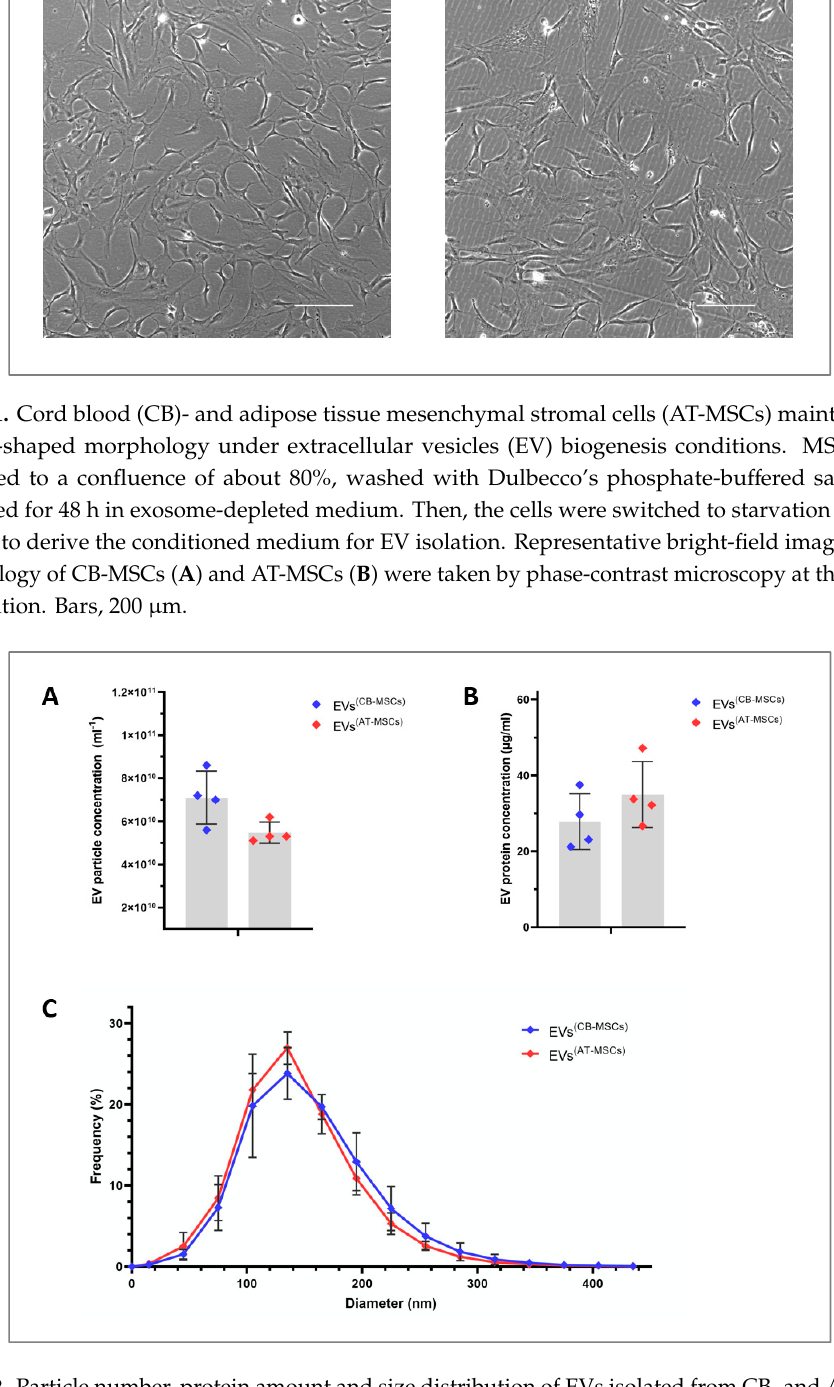
Figure 2. Particle number, protein amount and size distribution of EVs isolated from CB- and AT-MSCs. Particle concentration ( A ) and size distribution ( C ) of EV preparations were measured by nanoparticle tracking analysis. Protein content ( B ) was determined by the bicinchoninic acid assay. In ( A – C ), the results are mean values ± standard deviation (SD) obtained from four di ff erent donors per cell